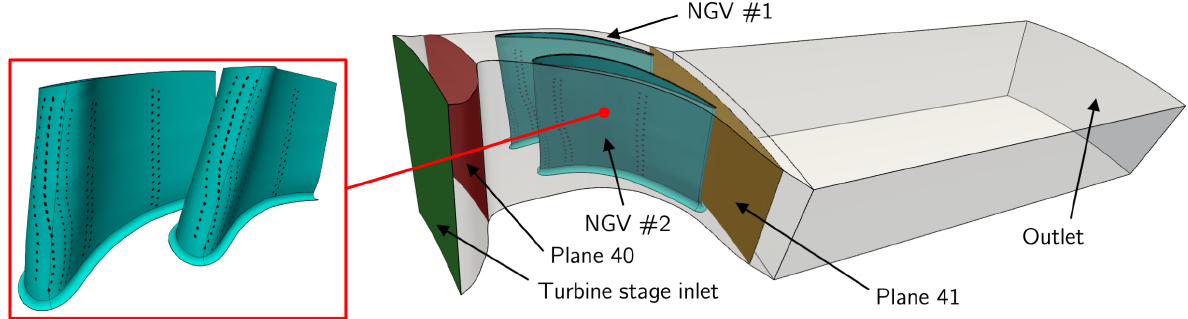
Figure 11. Isolated turbine configuration. Film holes are highlighted on the blade